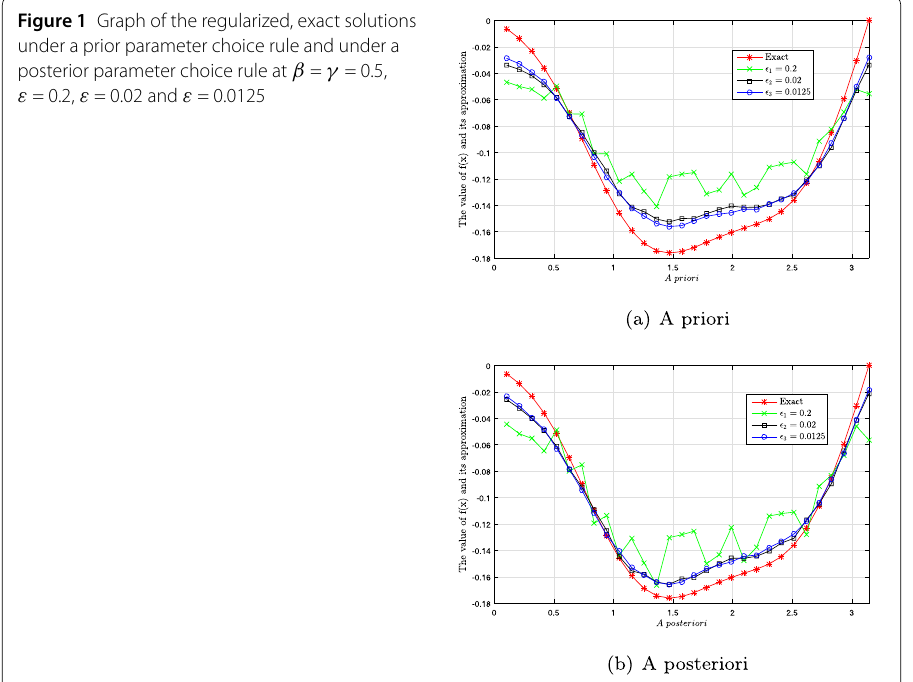
posterior parameter choice rule at β = γ = 0.5, ε = 0.2, ε = 0.02 and ε =